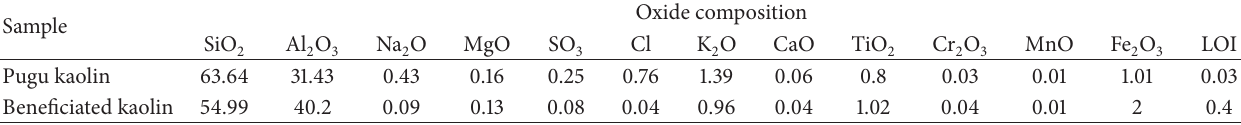
Table 3: Chemical composition of the raw materials.